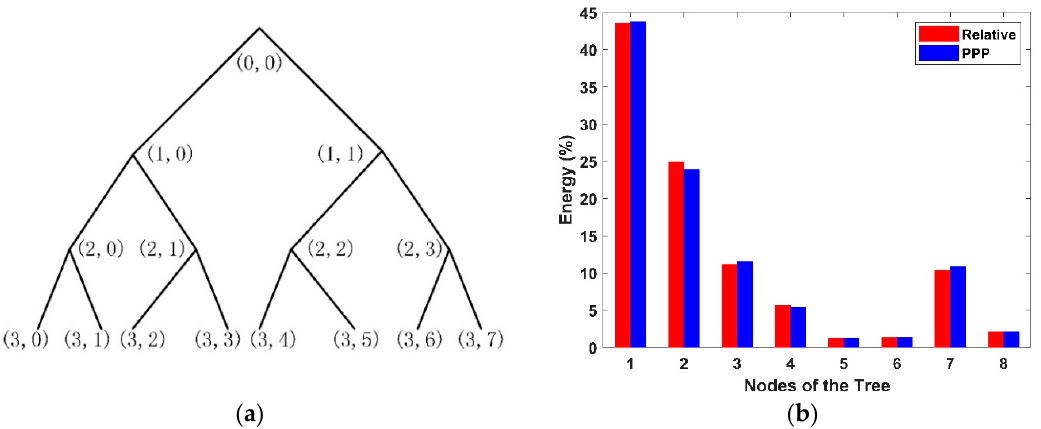
Figure 9. Wavelet tree and energy, ( a ) wavelet tree, ( b ) energy of nodes.